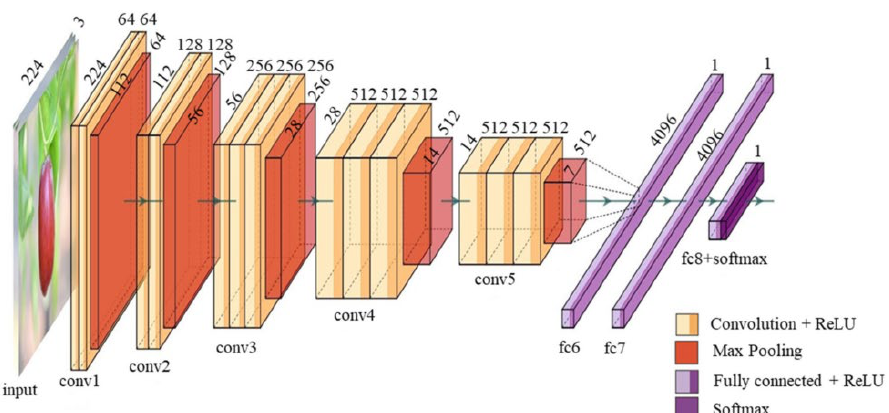
Figure 12. Architecture of VGG-16 [137].